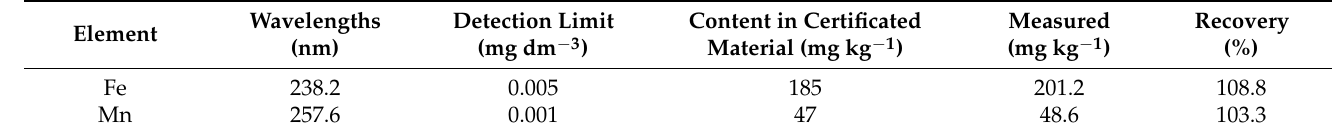
Table 2. Parameters of the applied atomic emission spectroscopy (AES)